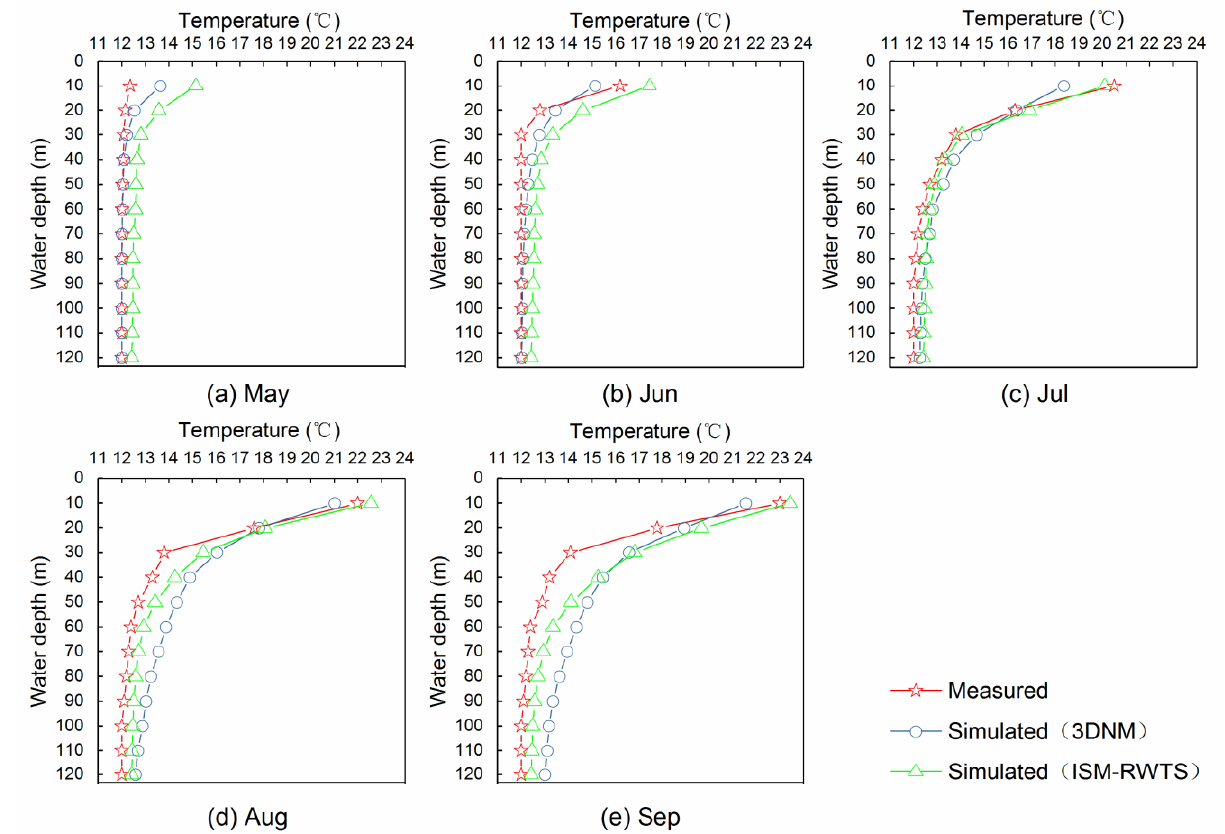
Figure 8. Comparison of measured instantaneous results and simulated by 3DNM and ISM-RWTS: ( a ) May, ( b ) June, ( c ) July, ( d ) August, ( e ) September. Table 3. Performance indicators of the various